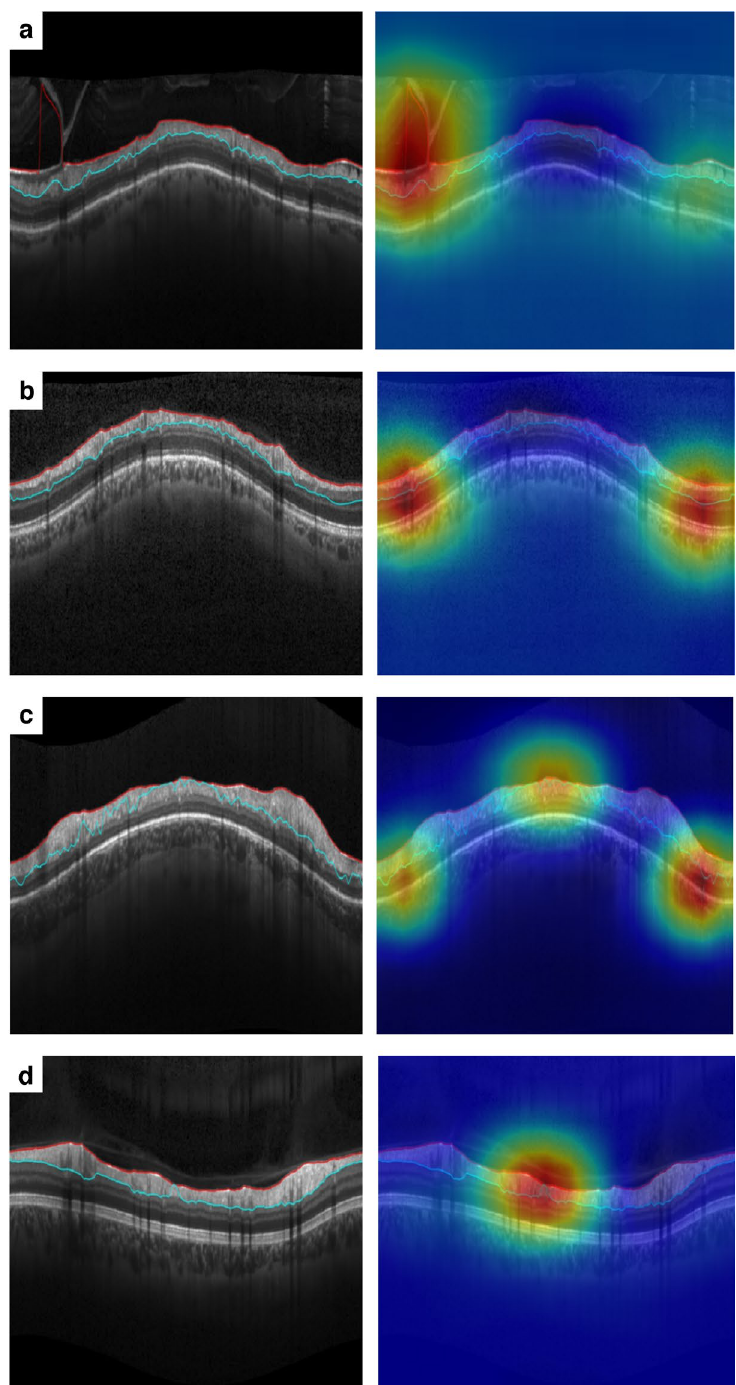
Figure 1. Spectral-domain optical coherence tomography (SDOCT) B-scans with segmentation errors correctly detected by both human graders and the deep learning algorithm. Class activation maps (heatmaps) on the right show the regions of the B-scans that had greatest weight in the deep learning algorithm classification. Probabilities of segmentation error given by the deep learning algorithm were all above 97.5% for these scans. ( a ) Segmentation error in the internal limiting membrane. ( b ) Segmentation error in the inner plexiform layer. ( c ) Multiple segmentation errors. ( d ) Small segmentation